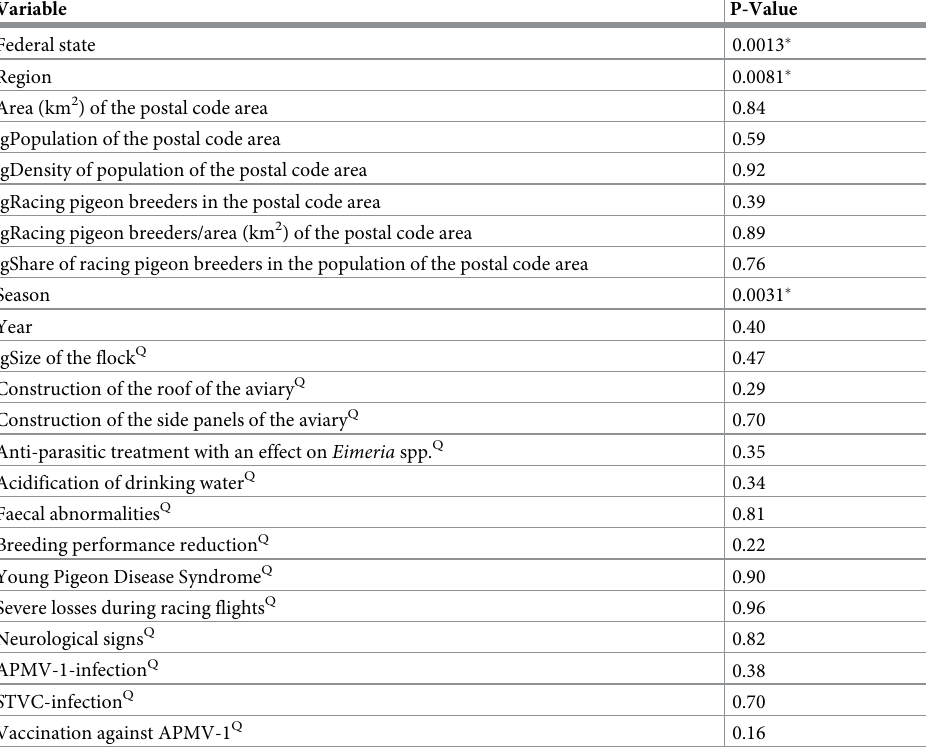
Table 4. Identification of correlating variables–p-Values of the simple logistic regression or chi-square-test con- sidering each variable separate (raw associations). Variables partially log-transformed (lg) if their distribution was skewed to the